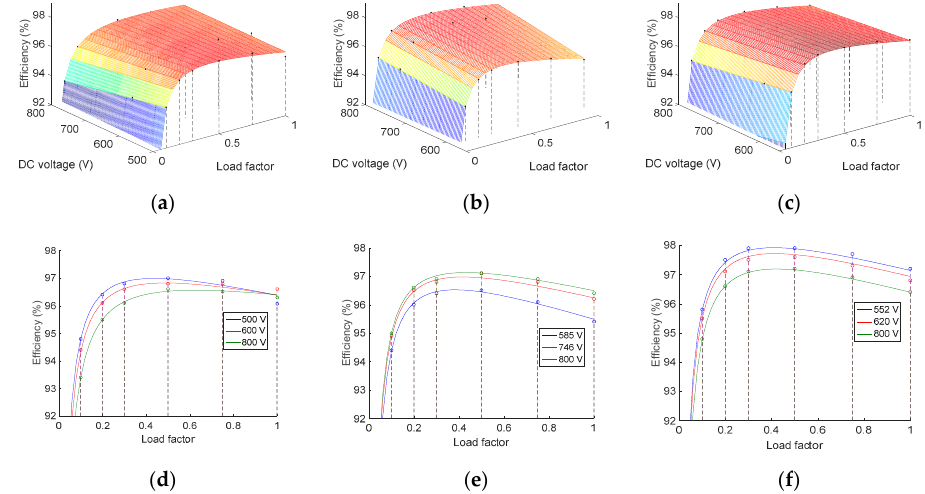
Figure 6. Efficiency surfaces and detail of curves for three values of the DC voltage calculated by means of the Rampinelli model. ( a ) and ( d ) Perfect Galaxy International Ltd EQX0250UV480TN. ( b ) and ( e ) Power-One ULTRA-750-TL-OUTD-4-US. ( c ) and ( f ) Power Electronics FS0900CU.